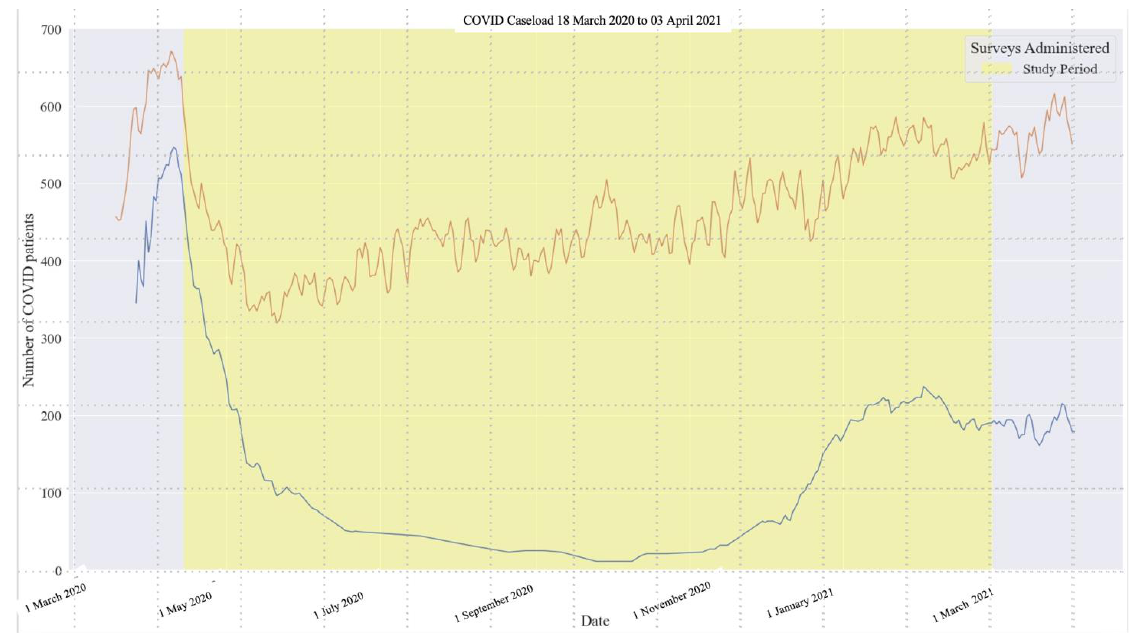
Figure 1. COVID Caseload and Total Hospital Census During Study Period. Note: The upper (brown) line depicts the total hospital census. The lower (blue line) depicts the COVID-19 caseload. The